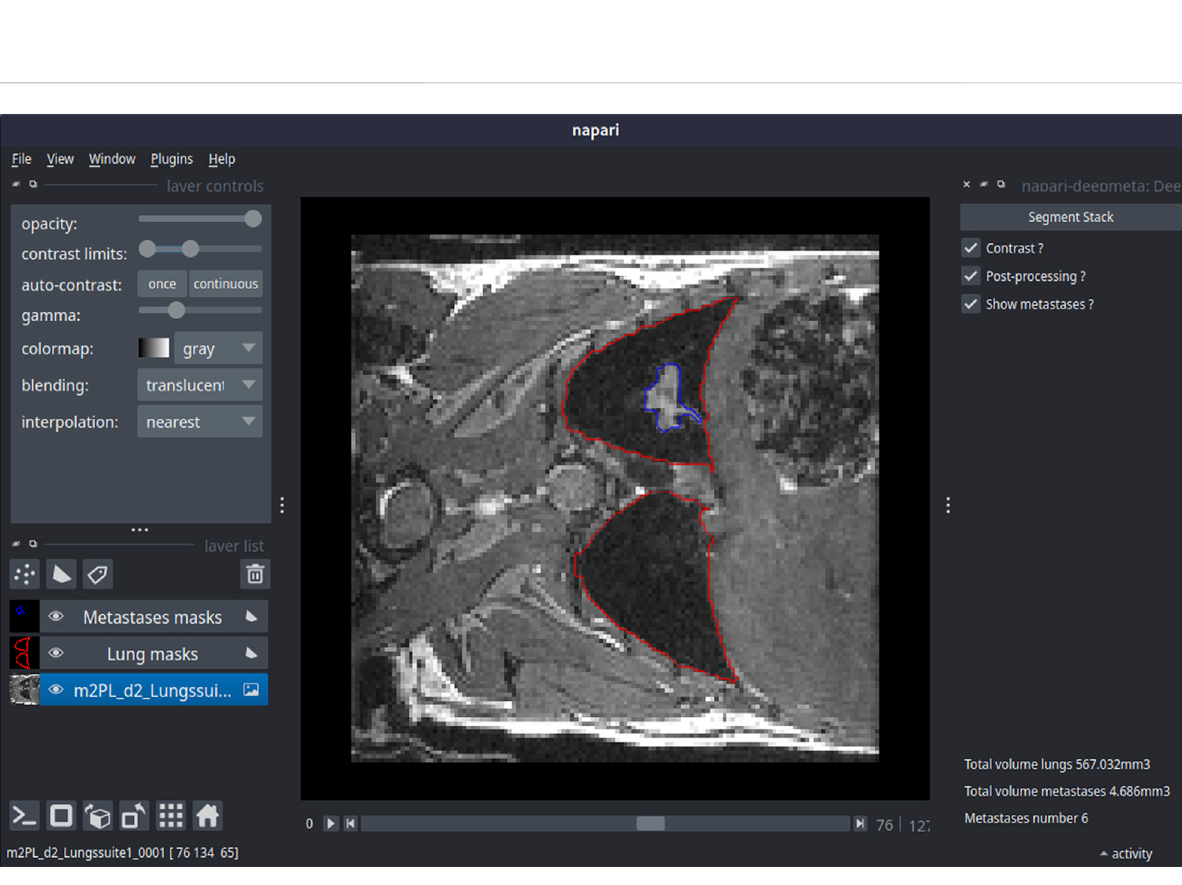
FIGURE 5 DeepMeta ’ spredictiononamousebearing4T1lungmetastasesusingthedeepmeta-napariplugin.Ontheleftisthecontrolpanelofthenapari interface allowing to adjust the image visualization parameters (top left) as well as the stack with contours that represent the segmentation of lungs and metastases. Lungs and metastases segmentation is shown in the central panel, in red for lungs and in blue for metastases. On the right is the DeepMeta plugin control panel. The resulting volumes for lungs and metastases are indicated on the bottom